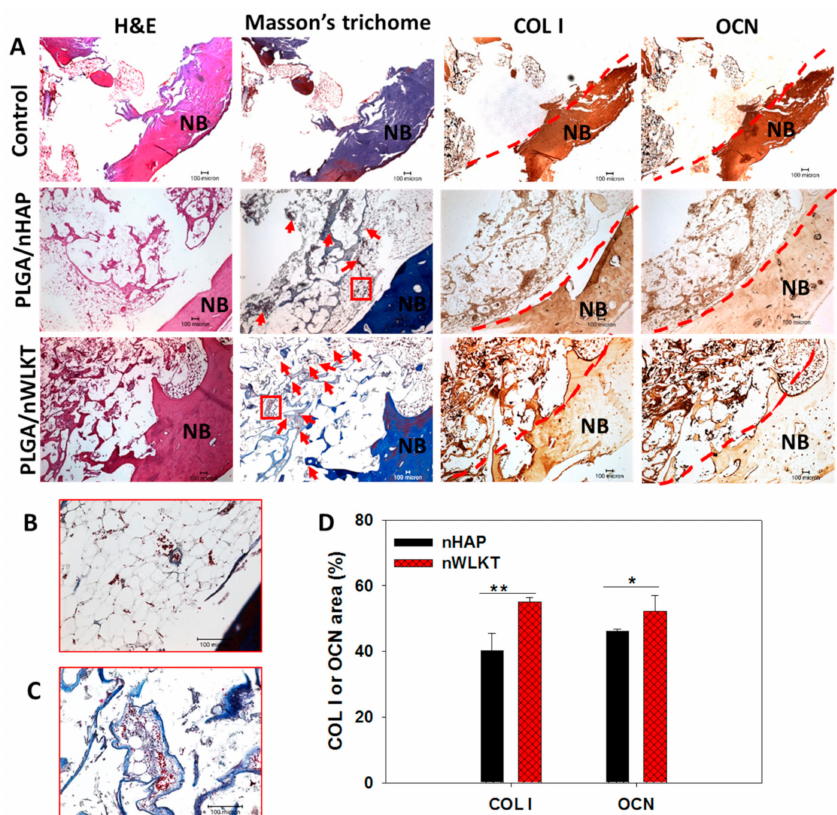
Figure 9. ( A ) The H&E, Masson’s trichrome and immunohistochemical (IHC) staining of COL I and OCN in the rabbit tibia defect repaired with PLGA / nHAP and PLGA / nWLKT microsphere sca ff olds (scale bar = 100 µ m). The red arrows indicate newly formed blood vessels and NB indicates native bone. The red squares in Masson’s trichrome staining images were further enlarged for PLGA / nHAP ( B ) and PLGA / nWLKT ( C ) to show the newly formed blood vessel. ( D ) The semi-quantitative analysis of protein expression by image analysis from IHC staining (* p < 0.05, ** p <